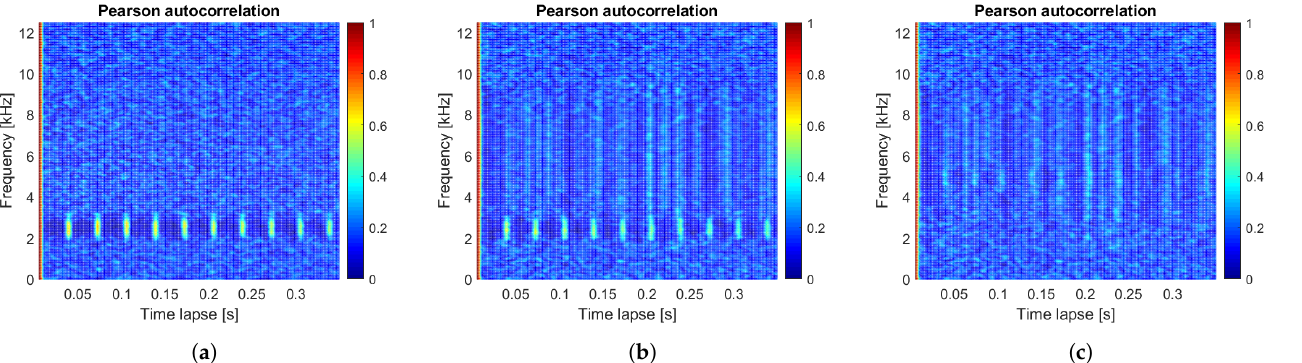
Figure 2. Pearson correlation map for Gaussian signal with a local fault ( a , b ) and heavy-tailed signal with a local fault, with a different carrier frequency of fault: 2.5 kHz ( a , b ) and 5 kHz ( c ), carrier frequency of non-cyclic: 6